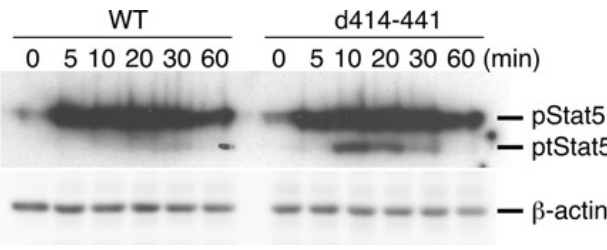
Figure 4. Signal transducer and activator of transcription 5 (STAT5) phosphorylation in response to IL-7 treatment in CTLL-2 cells expressing WT IL-7Rα and d414–441 mutant. Cells were starved of IL-2 for 8 h and stimulated with 100 ng/mL IL-7 for the indicated times. Whole cell lysates were subjected to sodium dodecyl sulfate polyacrylamide gel electrophoresis, and STAT5 activation was analyzed with immunoblotting using anti-phospho-STAT5 antibodies. Expression of β -actin was also examined with anti- β -actin antibodies as a loading control.